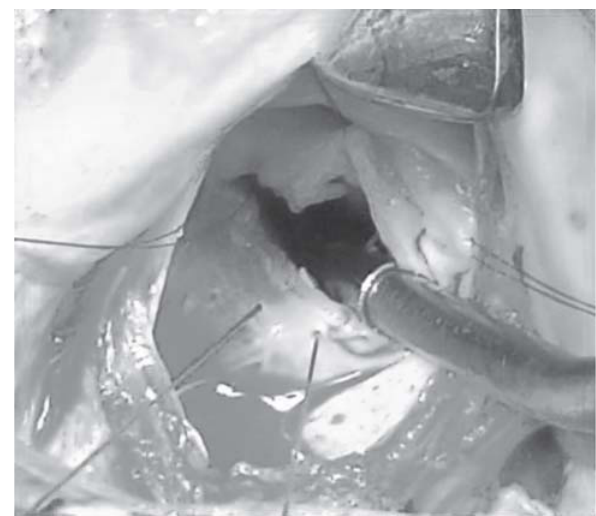
Fig. 1 – Desinserção do folheto posterior do anel. A incisão deve se estender de comissura a comissura